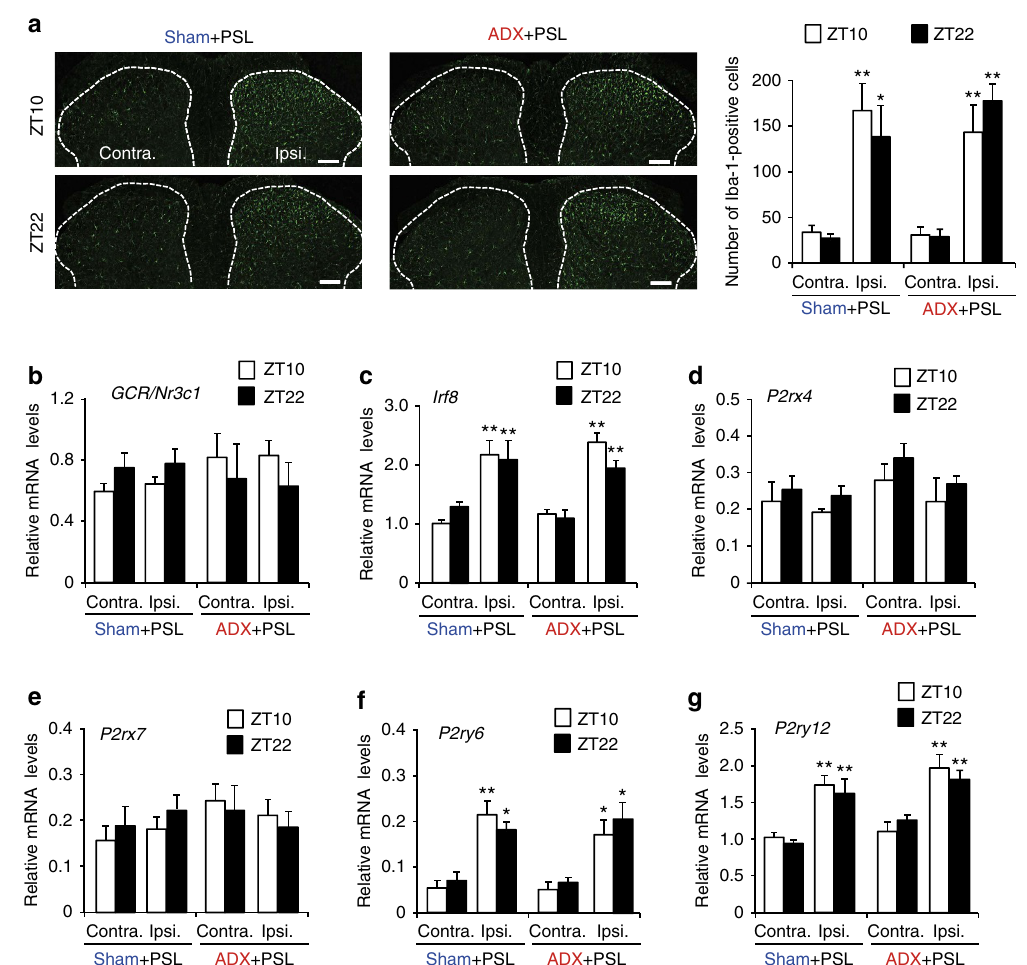
Figure 2 | Morphological and molecular alterations in the spinal cords of PSL mice. ( a ) Temporal profiles of Iba1-positive cells in the spinal cords of sham þ PSL and ADX þ PSL male mice. The dorsal horn areas are surrounded with dashed line. Scale bar, 100 m m. The right panel shows the quantification of the number of Iba1-positive cells (means ± s.e.m.; n ¼ 5). Tukey–Kramer’s post hoc tests (PHT) shows that the number of Iba1-positive cells in the ipsilateral (Ipsi.) side of sham þ PSL and ADX þ PSL mice is significantly higher than that in the contralateral (Contra.) side (** P o 0.01, * P o 0.05), whereas no significant difference is noted in the number of cells between the two time points ( F 7,32 ¼ 6.550, P o 0.001; ANOVA). ( b – g ) Temporal profiles of mRNA levels for GCR/ Nr3c1 , Irf8 , P2rx4 , P2rx7 , P2ry6 and P2ry12 in the spinal cords of sham þ PSL and male ADX þ PSL mice (means ± s.e.m.; n ¼ 5–6). ** P o 0.01, * P o 0.05 significantly different from contralateral sides in the corresponding groups ( F 7,36 ¼ 13.307, P o 0.001 for Irf8 , F 7,36 ¼ 7.586, P o 0.001 for P2ry6 , F 7,36 ¼ 9.544, P o 0.001 for P2ry12 ; ANOVA with Tukey–Kramer’s Fig. 3a, left panel). Similar time-dependent variations were also detected in ATP concentrations in the cerebrospinal fluid (CSF) of sham þ PSL ( P o 0.05; Supplementary Fig. 4a; Supplementary Method). This may have been due to diurnal variations in the release of ATP from cells in the spinal cord. The rhythmic pattern of spinal ATP release in male sham þ PSL mice resembled the overall oscillation in plasma and spinal CORT levels (Fig. 1b upper panel and Supplementary Fig. 2). In contrast, the oscillation in ATP release from spinal slices of male ADX þ PSL mice was severely dampened (Fig. 3a, right panel); the release of ATP from both the ipsilateral and contralateral sides remained low throughout the day P ¼ 0.369 for the ipsilateral side; F 5,28 ¼ 0.492, P ¼ 0.779 for the contralateral side). Time-dependent variations in ATP concentrations in the CSF were also diminished in female ADX þ PSL mice (Supplementary Fig. 4b). Since the single subcutaneous administration of CORT (30 mg kg (cid:2) 1 ) to male ADX þ PSL mice significantly enhanced ATP release from the ipsilateral and contralateral spinal slices ( F 3,16 ¼ 3.755, P ¼ 0.042